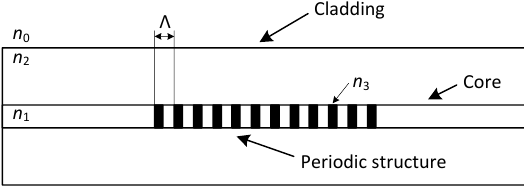
Figure 1. The structure of fiber Bragg grating.